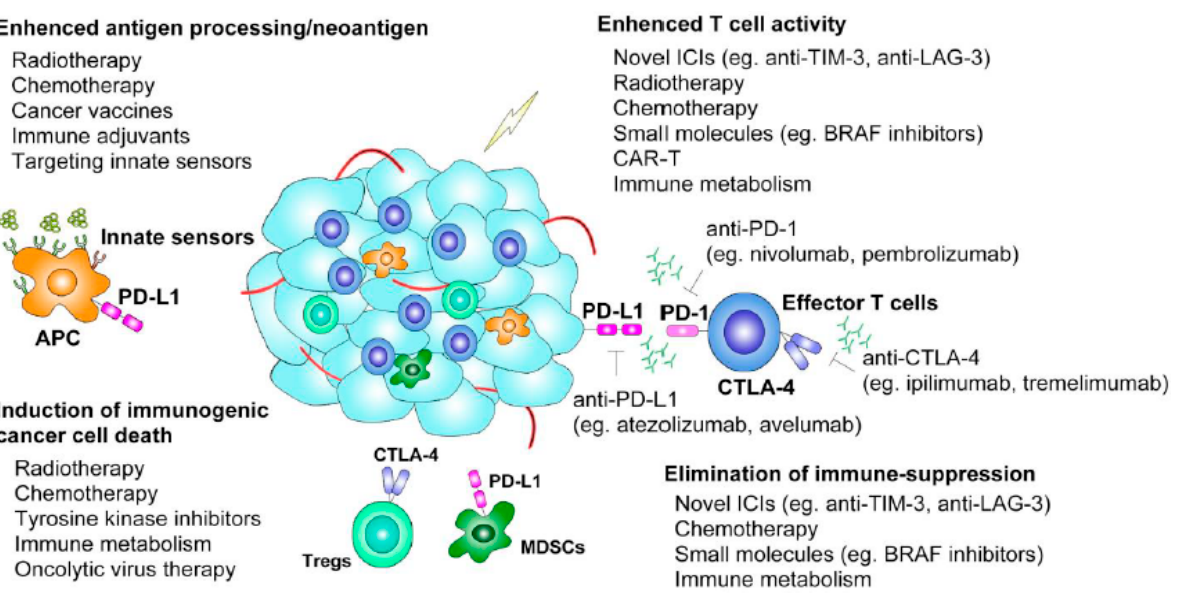
Figure 2. Summary of prospective combination strategies with checkpoint inhibition. Currently used monoclonal antibodies targeting PD-L1 (atezolizumab, avelumab), PD-1 (nivolumab, pembrolizumab), and CTLA-4 (ipilimumab, tremelimumab) as well as combination strategies involving various mechanisms for enhancing the efficacy of immune checkpoint inhibitors (ICIs) are presented. Novel immunotherapies, including oncolytic virus therapy and therapies targeting innate sensors, can either directly kill tumor cells or facilitate the presentation of tumor antigens in the generation of tumor-specific T cells. APC, antigen-presenting cell; BRAF, B-Raf proto-oncogene, serine/threonine-protein kinase; CAR-T cell, chimeric antigen receptor T cell; CTLA-4, cytotoxic T-lymphocyte-associated protein 4; LAG-3, lymphocyte-activation gene 3; MDSC, myeloid-derived suppressor cell; PD-1, programmed cell death protein 1; PD-L1, programmed cell death ligand 1; TIM-3: T cell immunoglobulin and mucin-domain-containing molecule 3; Tregs, regulatory T cells.